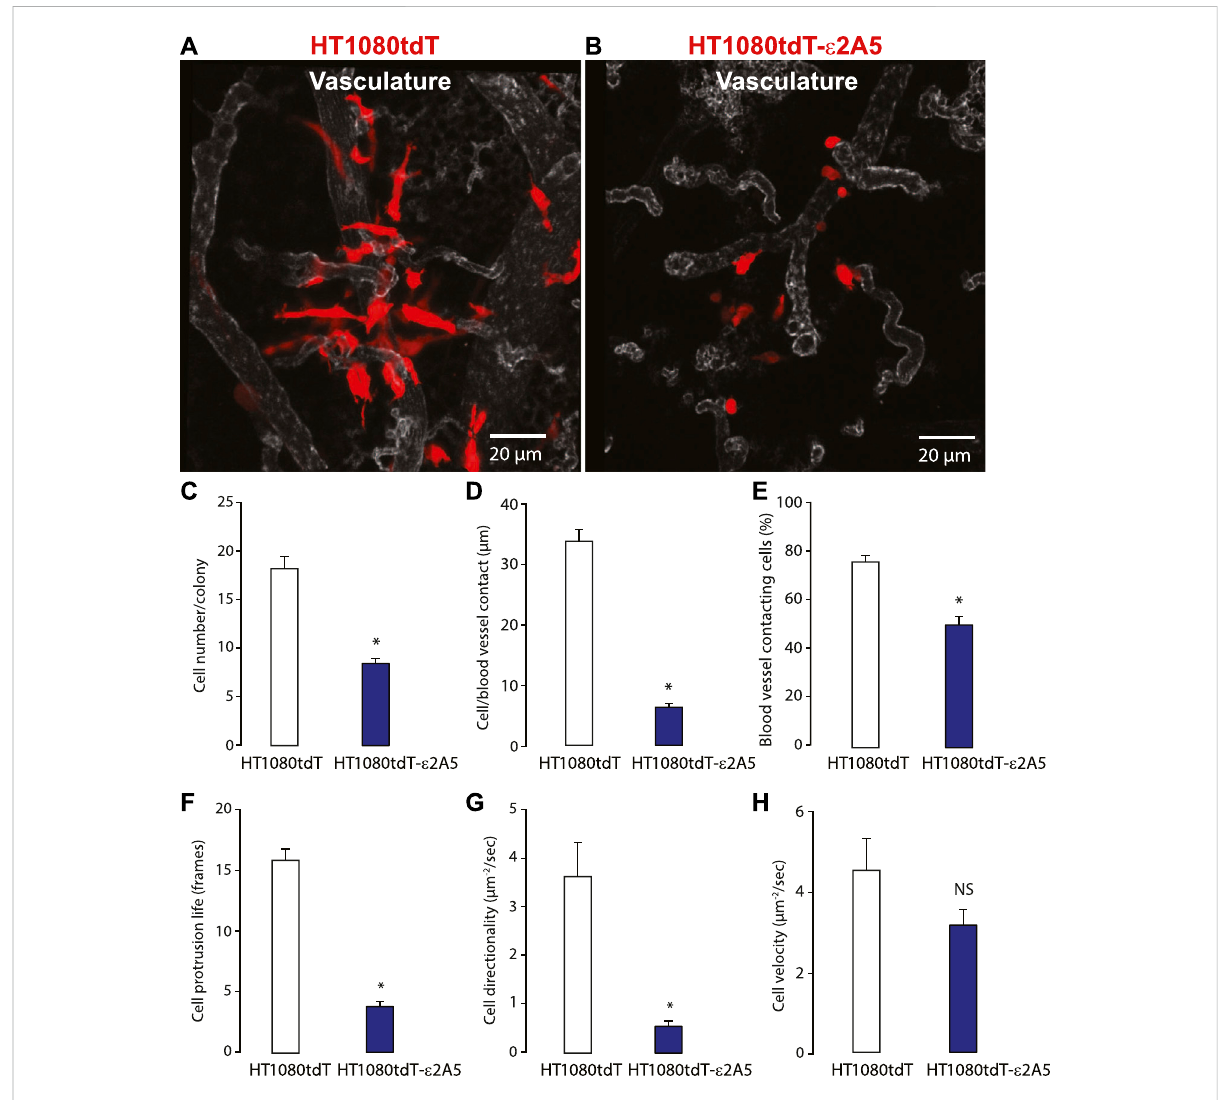
FIGURE 6 Analysis of metastatic behaviour of the HT1080tdT and HT1080tdT- ε 2A5 using the chicken embryo chorioallantoic membrane (CAM) technique. (A) and (B) . Images of HT1080tdT (A) and HT1080tdT- ε 2A5 cells (B) in chicken embryo CAM vasculature. The corresponding time-lapse video is shown in the Supplementary Video S1. (C – H) Quantitative analyses of cell number per colony (C) ; cell to blood vessel contacts (D,E) ; cell protrusion (F) ; cell directionality and cell velocity (H) . * p < 0.0001; n = 3; NS, not signi fi cant. The images shown are representative of more than 3 biological